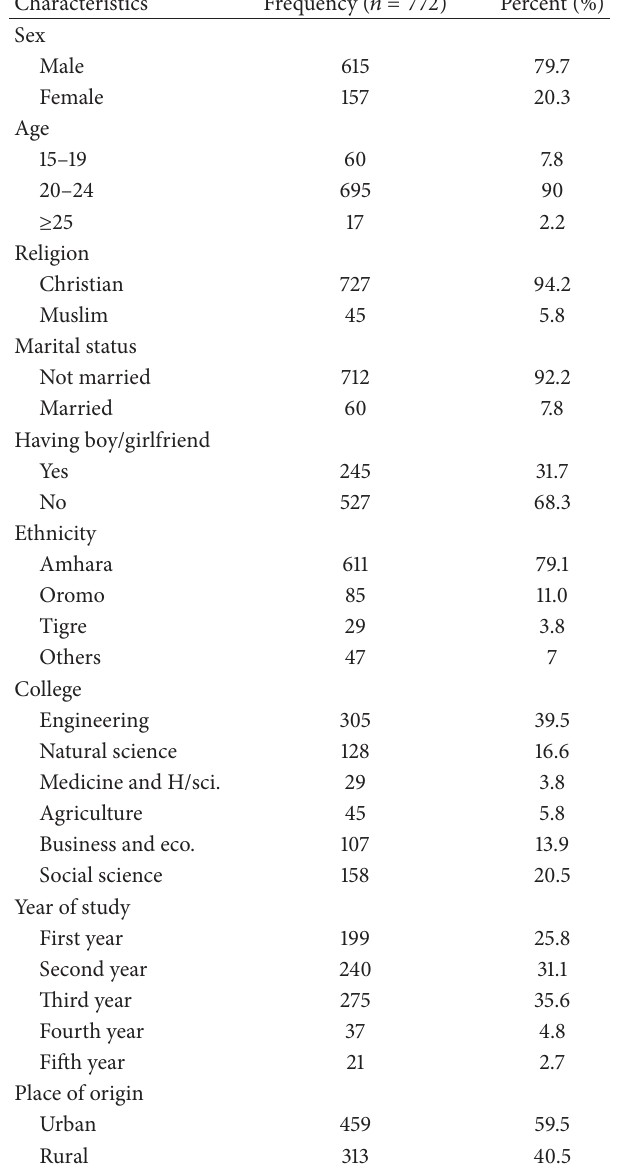
Table 1: Demographic characteristics of the university students, BDU, April 2012.